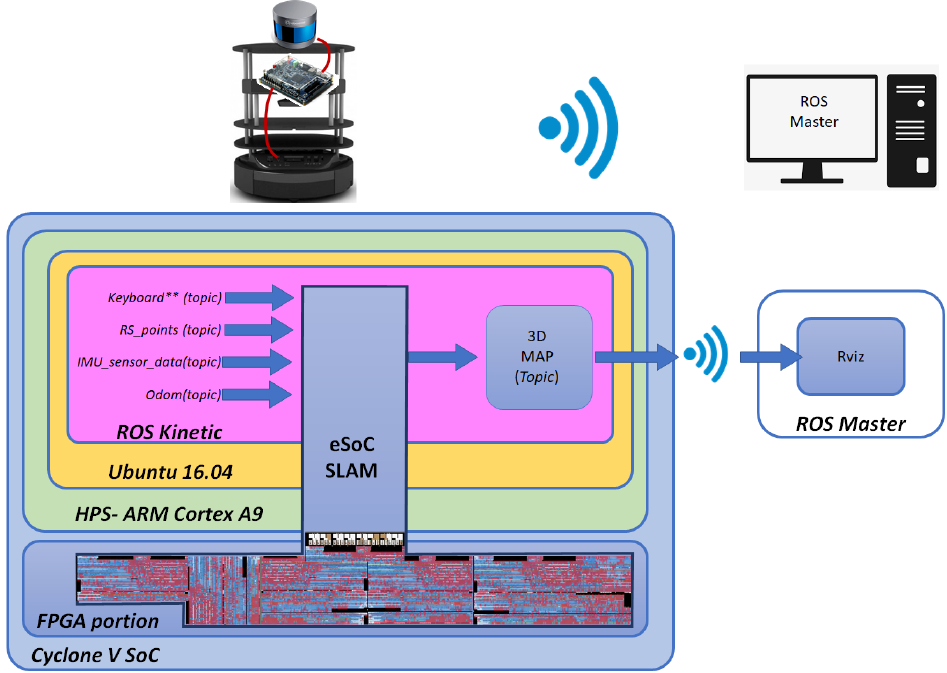
Figure 14. Interconnection between the Turtlebot 2, LiDAR RS-16, Cyclone V SoC System and